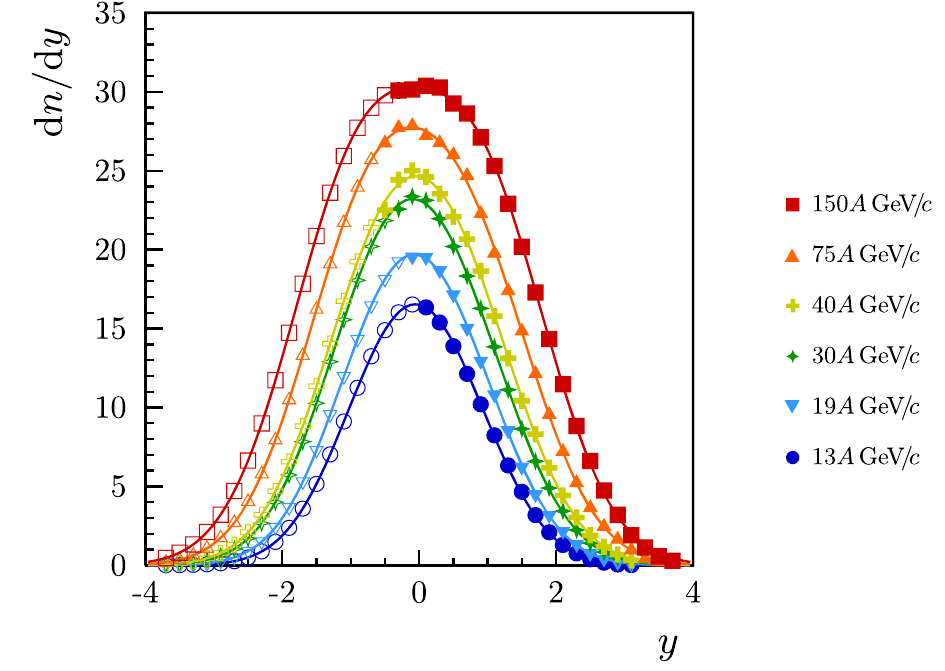
Fig. 18 Rapidity distributions d n / d y for all six beam momenta. Measured points are shown by full markers, values extrapolated by the fit function (see text) are plotted by open markers. All uncertainties are smaller than the symbol